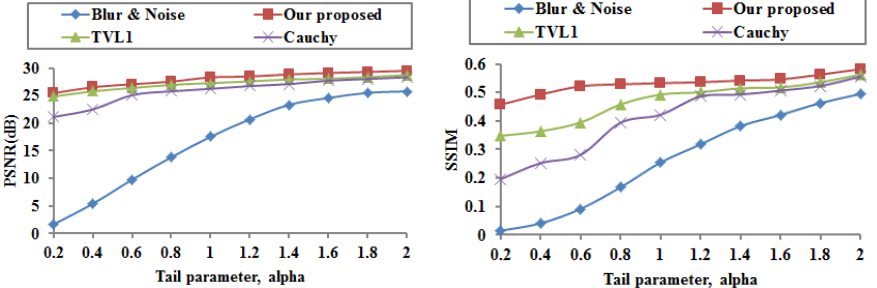
Figure 4. Performances of the blur and noisy images and the recovered images at different tail parameters